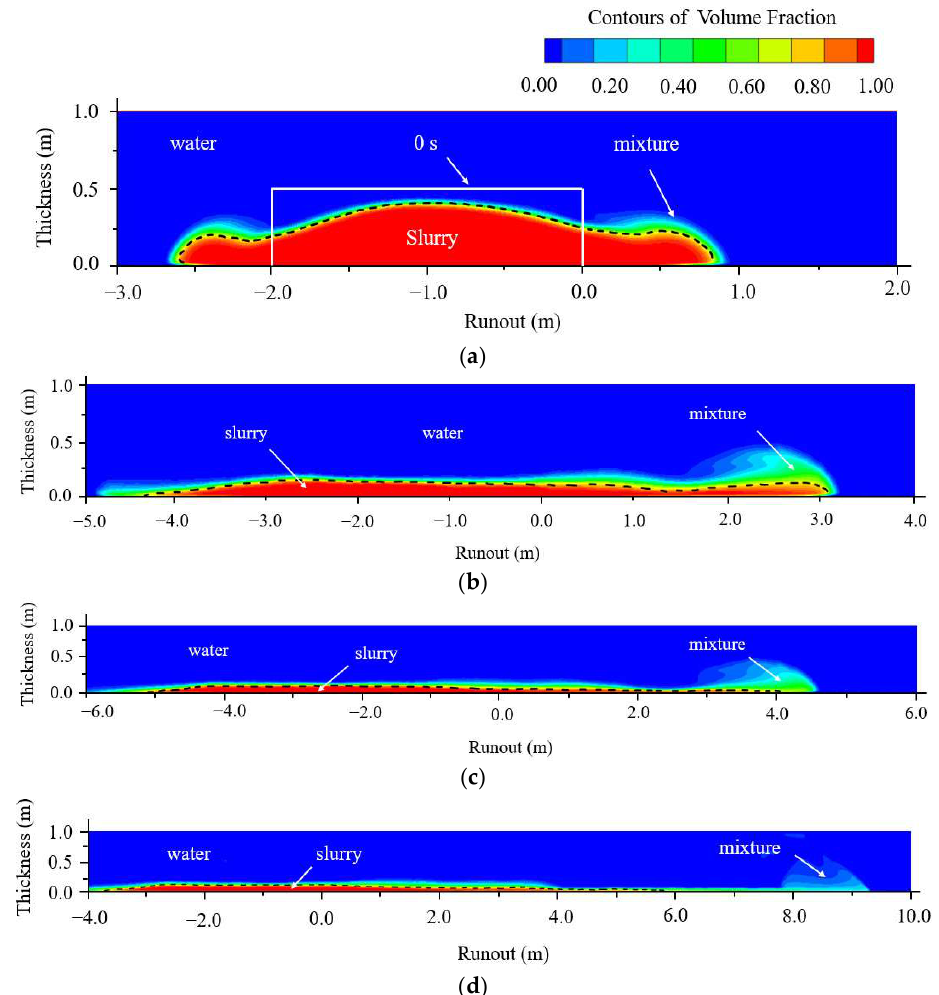
Figure 7. Volume fraction contours of the slurry at different points in time. ( a ) 1s. ( b ) 3.5 s. ( c ) 6 s. ( d ) 15 s.